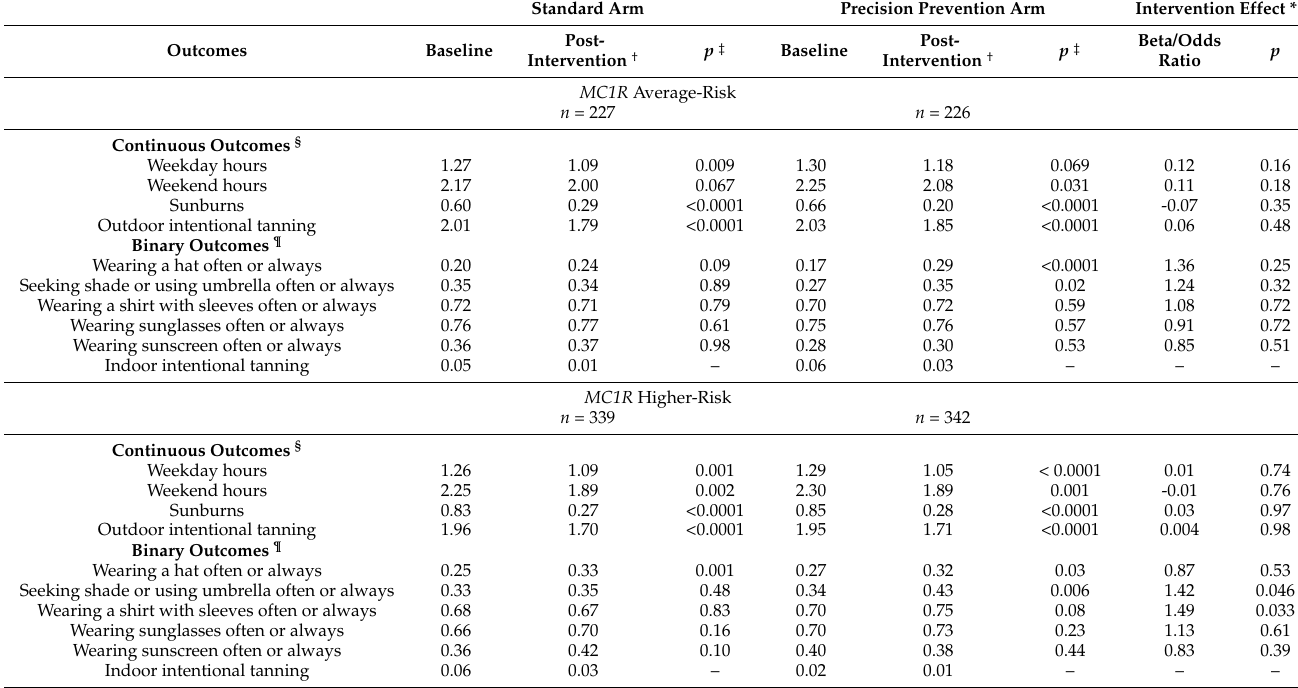
Table 2. Primary prevention outcome measures at baseline and post-intervention and intervention effects by MC1R risk